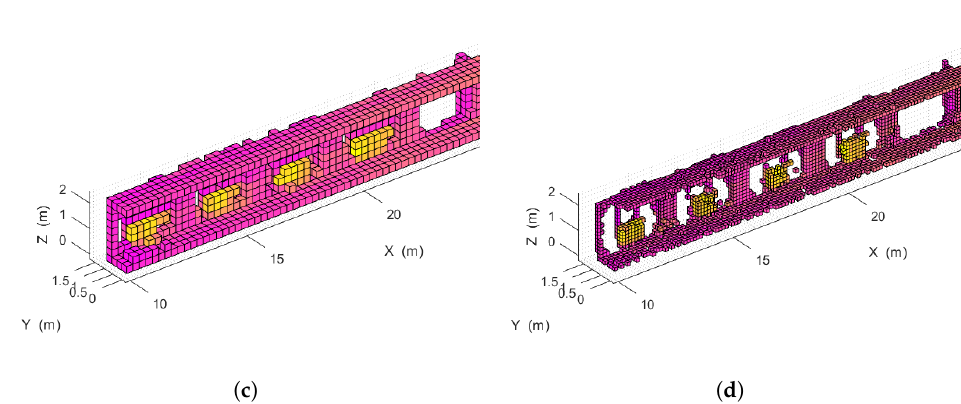
Figure 9. ( a ) Left side of the low resolution temperature distribution map relative to the indoor test environment. ( b ) Left side of the high resolution temperature distribution map relative to the same environment. ( c ) Detail of the low resolution indoor temperature distribution map. ( d ) Detail of the high resolution indoor temperature distribution map.